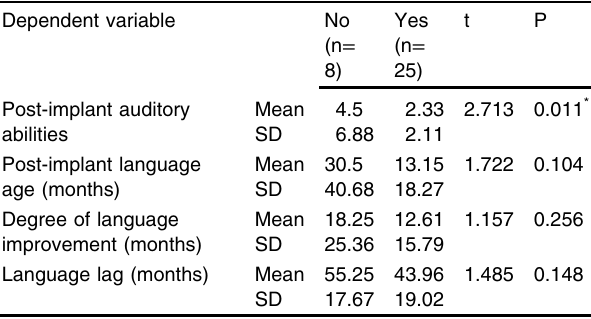
Table 4 Relationship between regularity of hearing aid usage and dependent variables Dependent variable